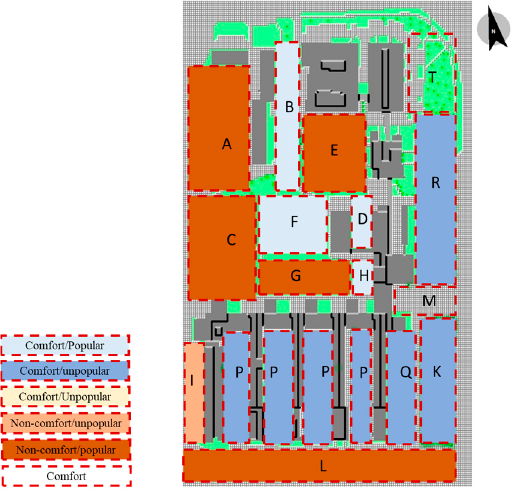
Figure 17. Comparison between the areas that are more popular for different activities and the comfort or non-comfort areas based on PET